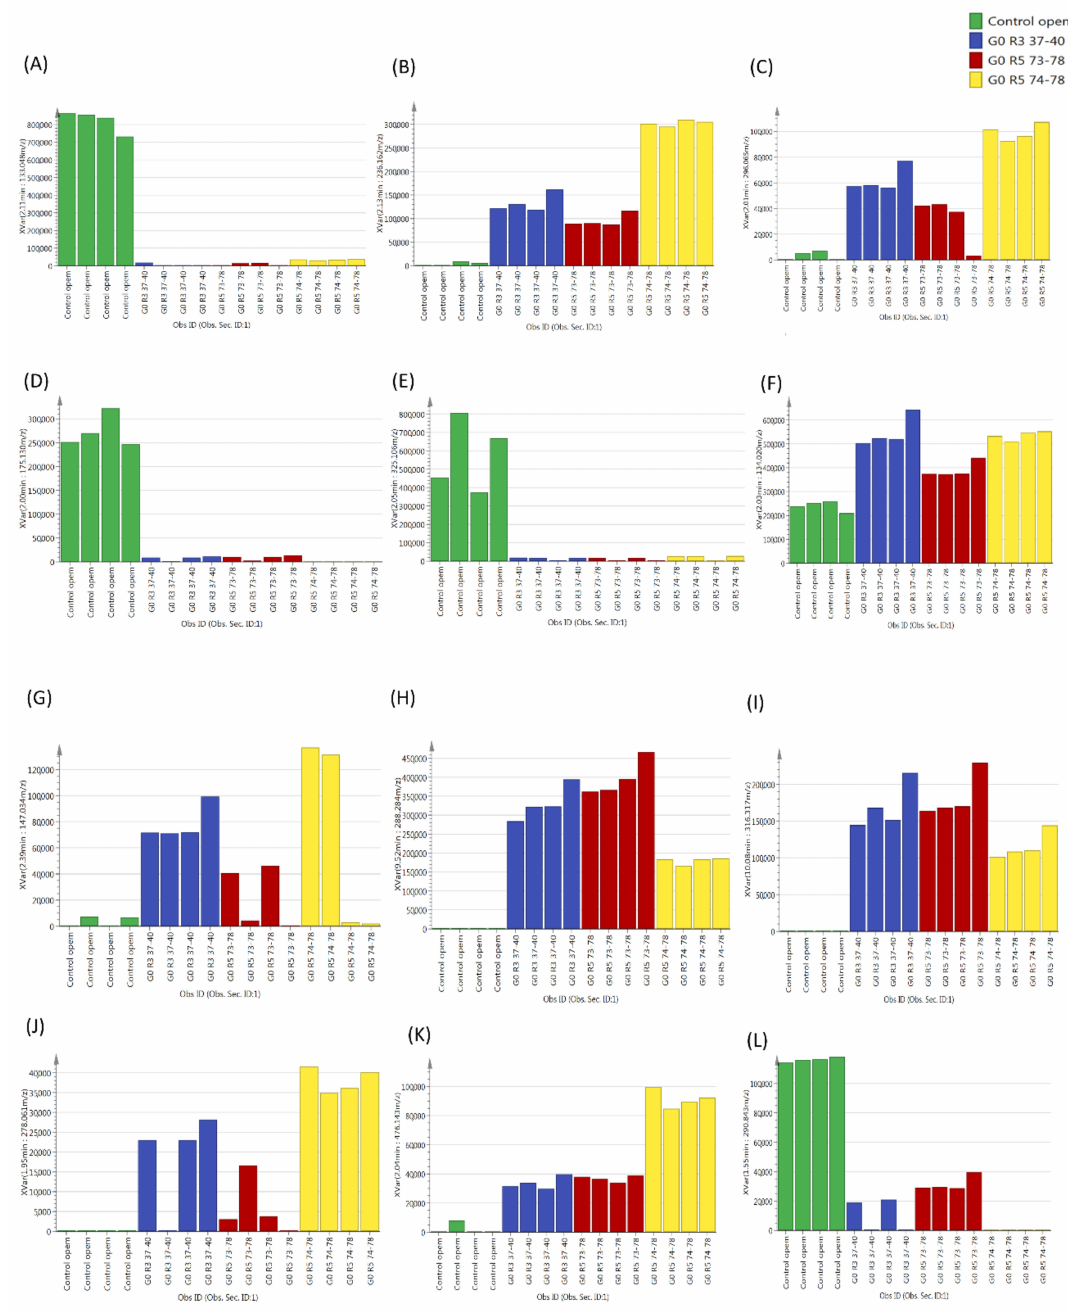
Figure 4. Representative ion intensity for the m / z value ( A ) 133.048 (Retention Time (RT) 2.11 min), ( B ) 236.162 (RT 2.13 min), ( C ) 296.065 (RT 2.01 min), ( D ) 175.130 (RT 2.00 min), ( E ) 325.106 (RT 2.05 min), ( F ) 134.020 (RT 2.03 min), ( G ) 147.034 (RT 2.39 min), ( H ) 288.284 (RT 9.52 min), ( I ) 316.317 (RT 10.08 min), ( J ) 278.061 (RT 1.95 min), ( K ) 476.143 (RT 2.04 min) and ( L ) 290.843 (RT 1.55 min) across 16